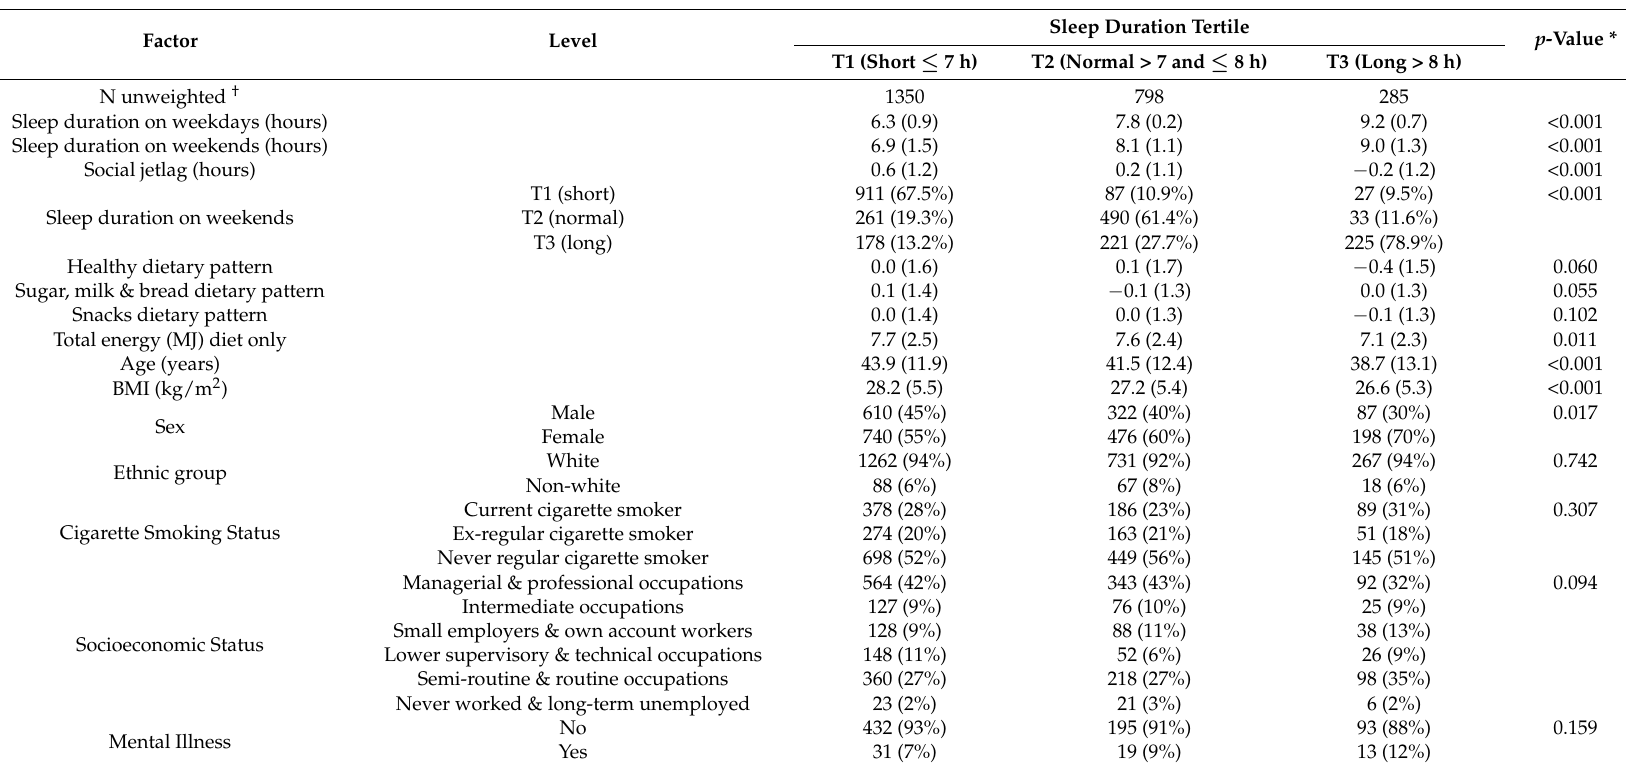
* p -Values are provided taking into consideration complex survey design and weighted sample. Singleton units were centred to enable estimation of standard errors based on the distance of strata from the grand mean. † N unweighted for complete-case model including mental illness as a covariate is 783. Abbreviations: T, tertile; N, number; MJ, millijoules; BMI, body mass index; kg, kilograms; m,